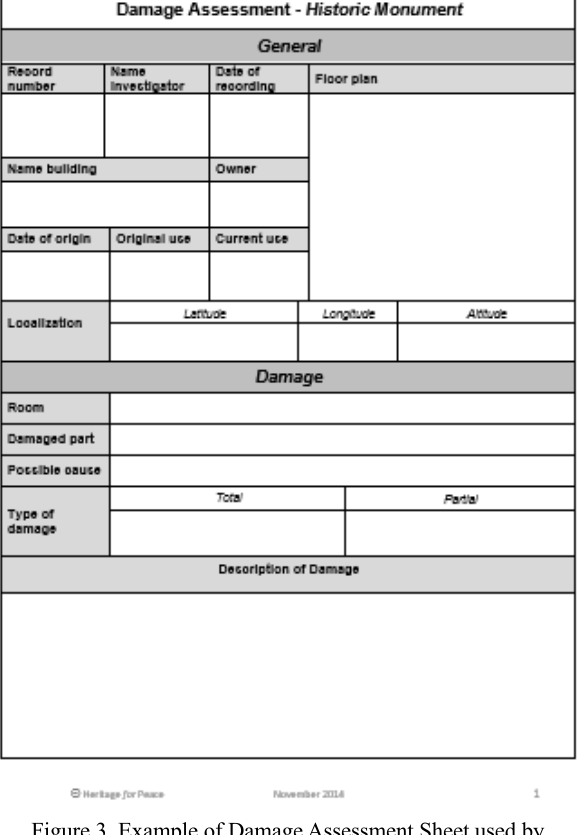
Figure 3. Example of Damage Assessment Sheet used by Heritage for Peace in previous